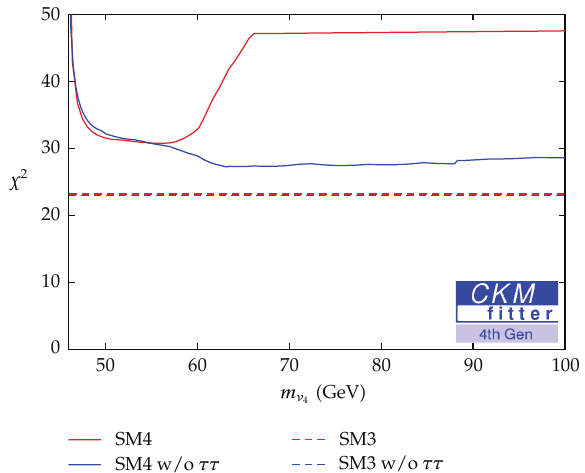
Figure 9: Best fit results in dependence of the mass of the fourth neutrino. As soon as 𝐻 → 𝜏 + 𝜏 − is included, the only remaining possibility for the SM4 is to open up the decay channel 𝐻 → 𝜈 4 𝜈 4 . Figure from